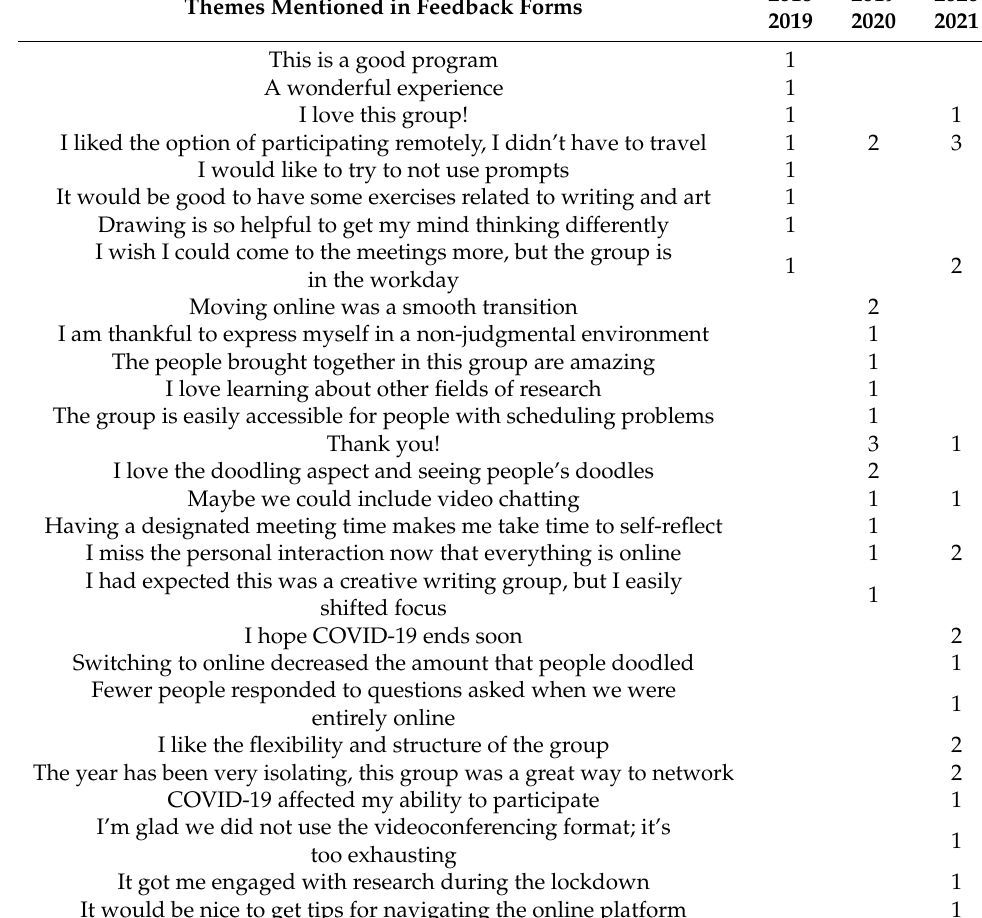
Table 10. Themes Mentioned in Responses Provided on the April Feedback Forms to Do You Have Other Thoughts/Comments on Your Experience as a Participant in the HeNReG this Term (Especially as a Result of COVID-19) for Each of the Three Most Recent Academic Years in Order of Receipt of Feedback Forms from Group